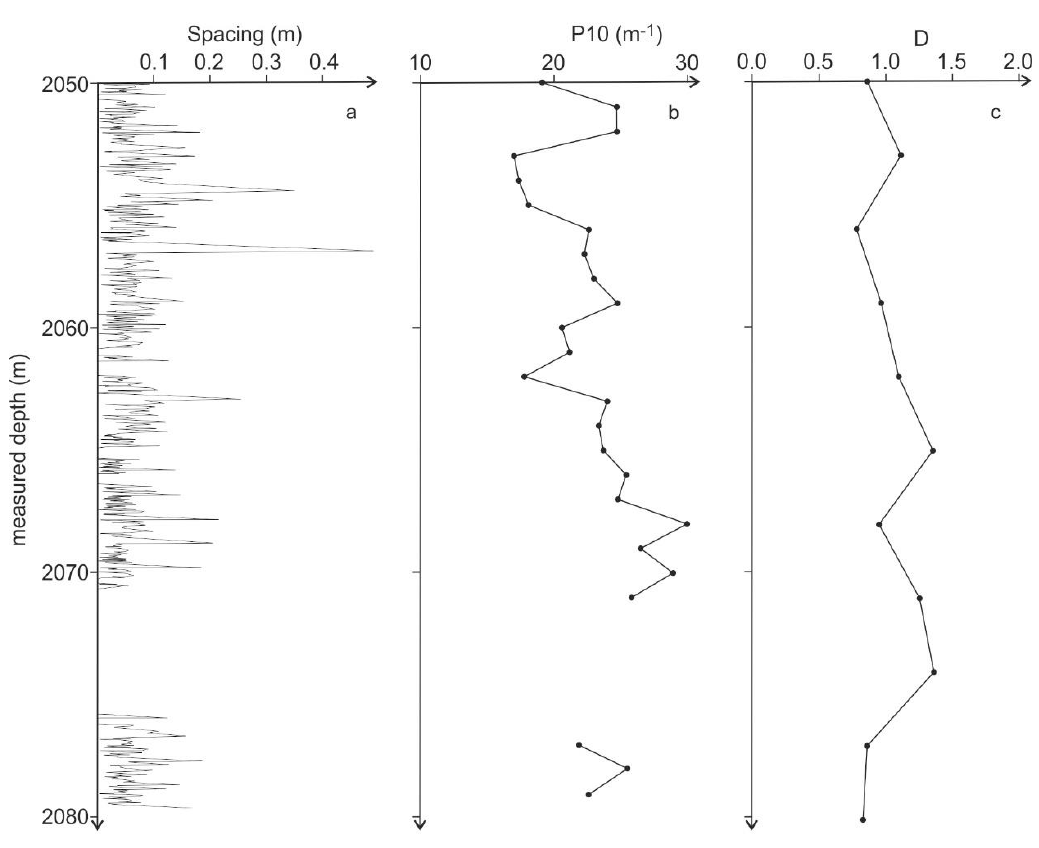
Figure 10. Fracture length distribution measured along the A-1 well. Inset: the log L − logN( L ) plot of the histogram for estimating the length exponent E.